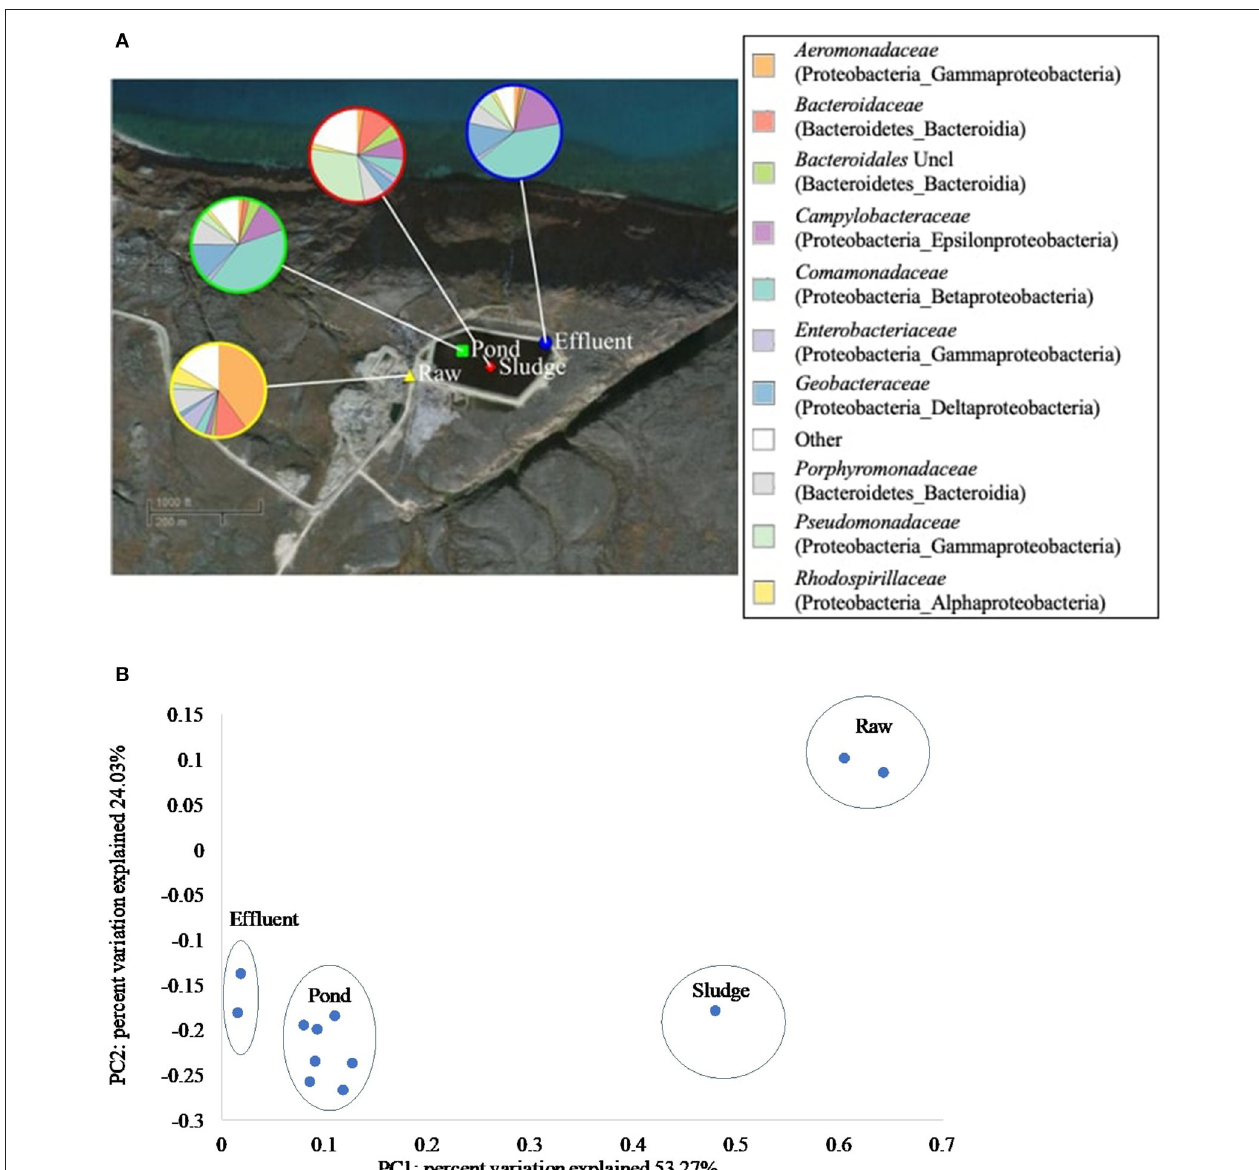
FIGURE 4 | Composition and phylogenetic beta-diversity of bacterial communities along the Pond Inlet WSP treatment train in September 2014. (A) Relative abundance of bacterial families (top 10 of 269 families) in wastewater samples collected along the treatment process. The legend shows the bacterial families with the phylum and class names listed in brackets. Uncl: unclassified. Other: sum of bacterial families with relative abundances below 10%. (B) PCoA plot presented the phylogenetic beta-diversity of bacterial communities measured by the weighted UniFrac